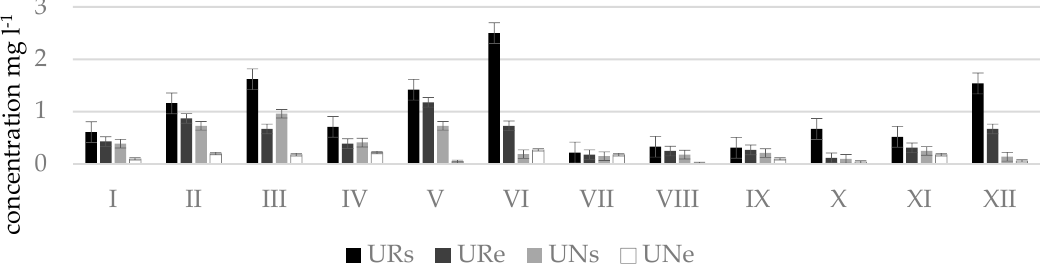
Figure 7. Phosphate concentrations ( PO (cid:2872)(cid:2871)(cid:2879) ) in natural (N) and regulated (R) stretches of Uogis stream.